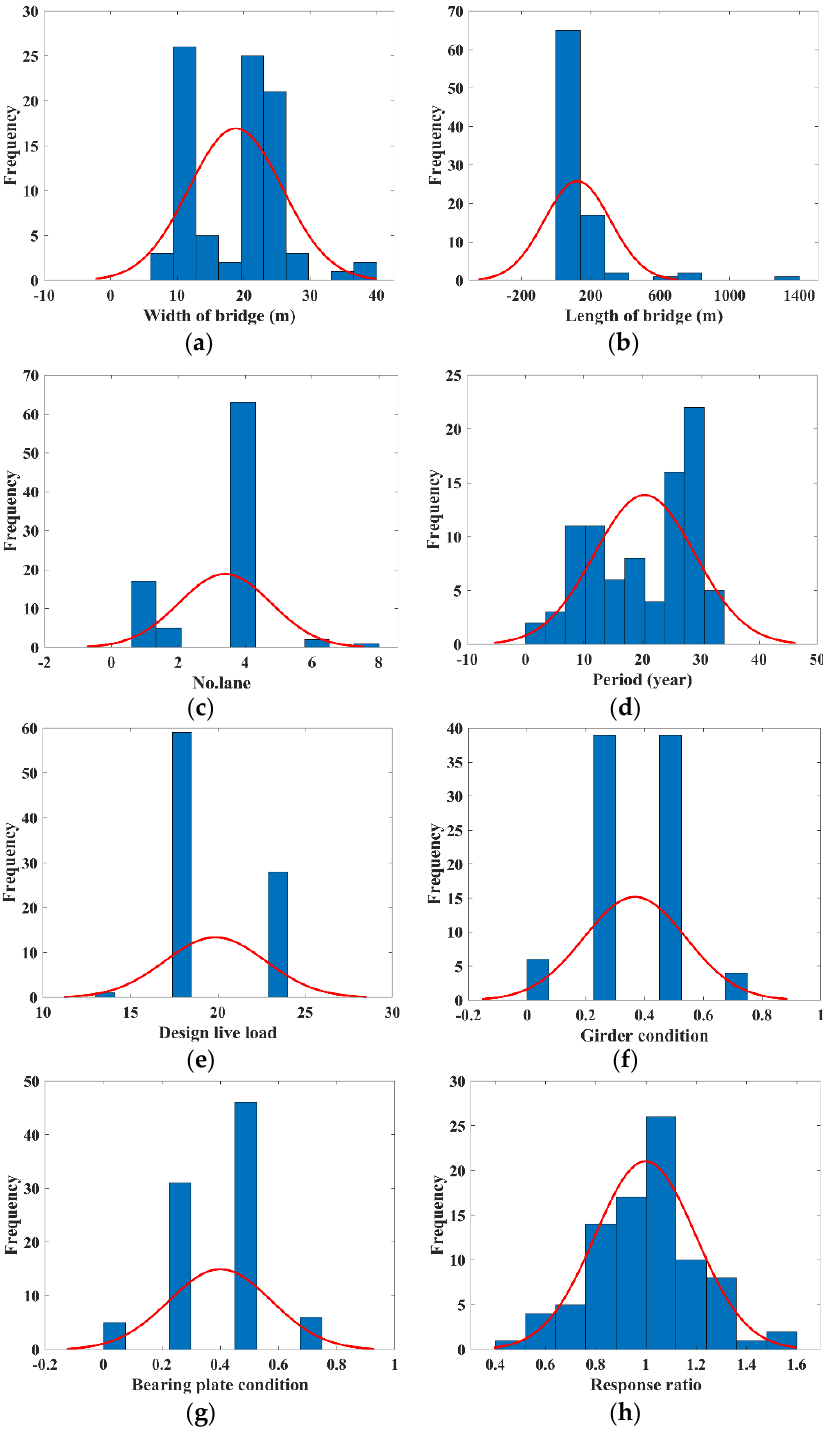
Figure 8. Distribution of input and target parameters. ( a ) Input parameter 1. ( b ) Input parameter 2. ( c ) Input parameter 3. ( d ) Input parameter 4. ( e ) Input parameter 5. ( f ) Input parameter 6. ( g ) Input parameter 7 . ( h ) Target.